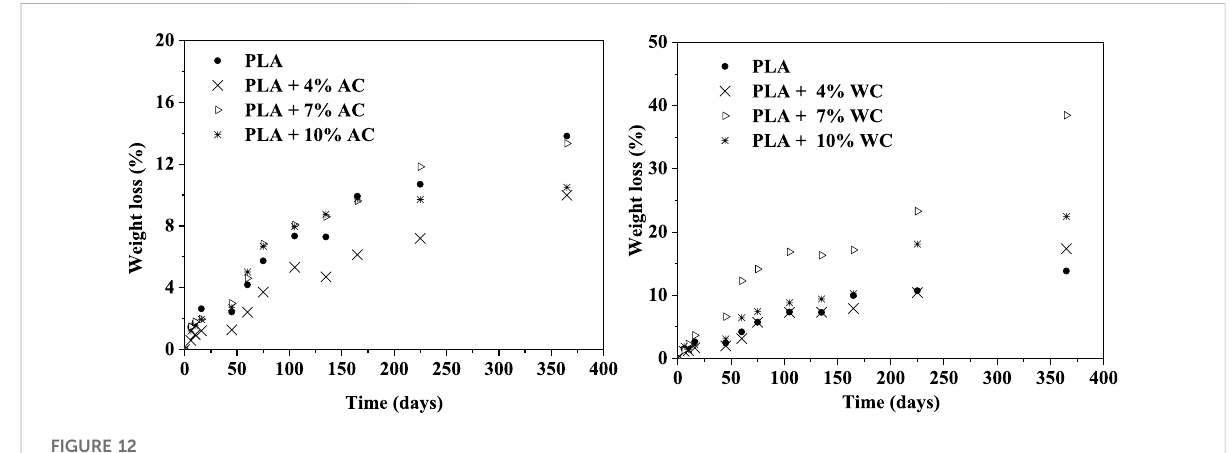
FIGURE 12 Weight losses of PLA, PLA/AC and PLA/WC composites during the soil burial test.